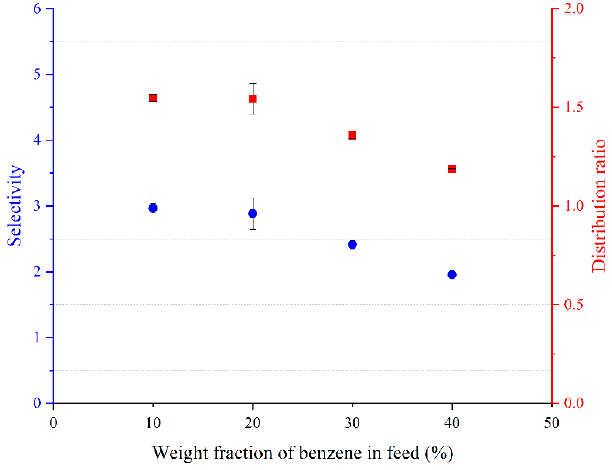
Figure 5. Variation of the distribution ratio and selectivity with benzene weight fraction in the